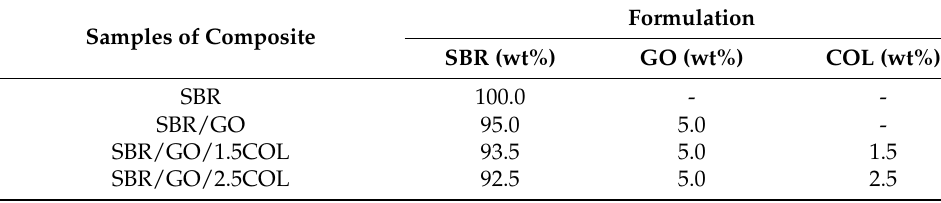
Table 1. Denotations and formulation of prepared SBR composite. Samples of